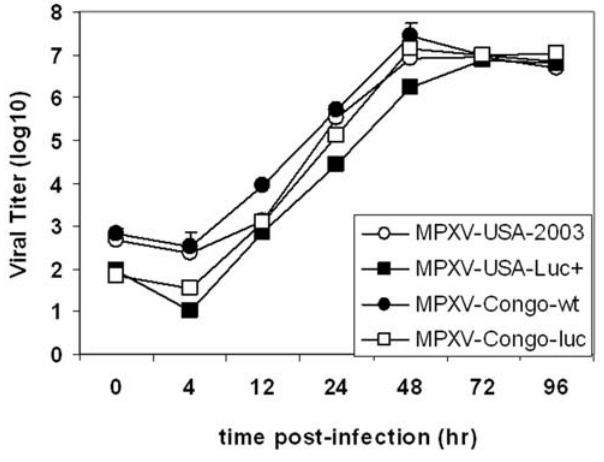
Figure 1. One-step growth curves for parental (MPXV-Congo, MPXV-USA-2003) and progeny recombinant (MPXV-Congo- Luc + , MPXV-USA-Luc + ) viruses. Vero cell monolayers were infected at multiplicity of infection (MOI) of 0.1 with parental (MPXV-Congo, MPXV-USA-2003) or with progeny (MPXV-Congo-Luc + , MPXV-USA-Luc + ) strains. After allowing for attachment (30 min), cells were washed twice with PBS to remove unattached virus. Then fresh medium as added and plates were incubated at 37 u C 5% CO2. At various intervals thereafter, three wells per virus strain were harvested (media and cells) and placed at 2 70 u C. After three cycles of freezing and thawing, the samples were sonicated and virus titers were determined by serial dilution and infection of Vero cell monolayers. Plaques were visualized by staining with 0.1% crystal violet in 20% ethanol and virus titers determined as described elsewhere